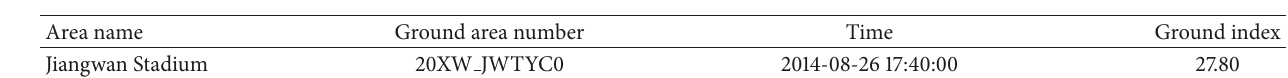
Table 2: Ground index